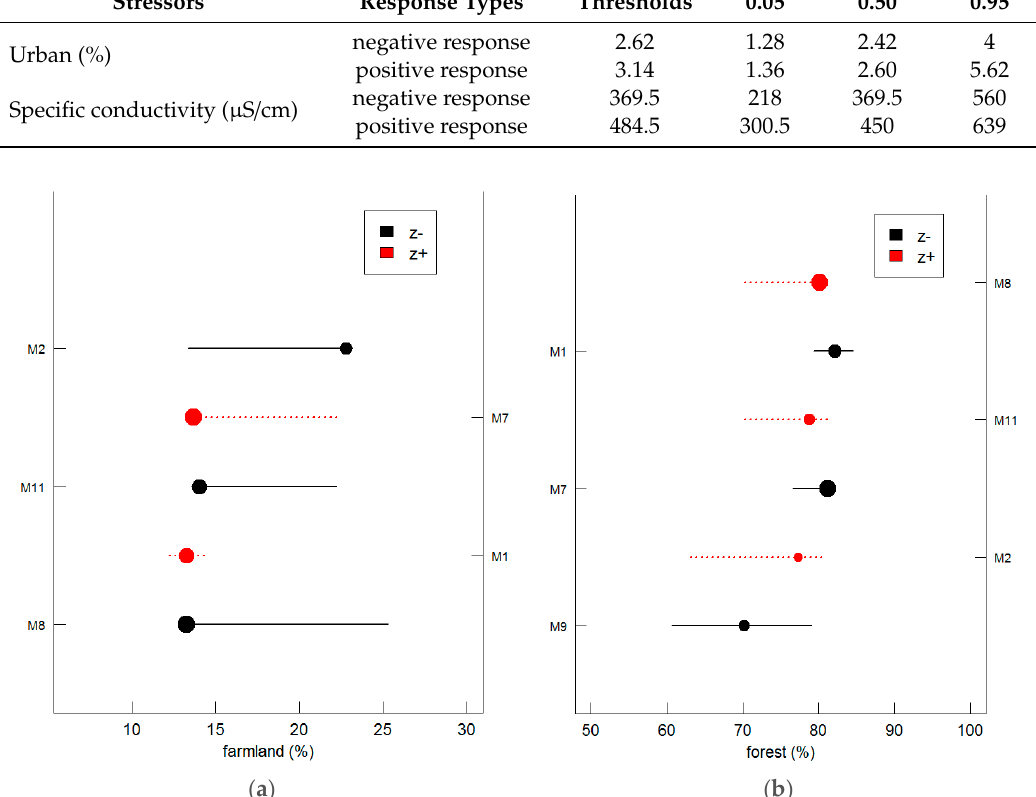
Figure 4. The responses and thresholds of fish functional structure metrics to farmland cover ( a ) and forest cover ( b ) in TITAN.